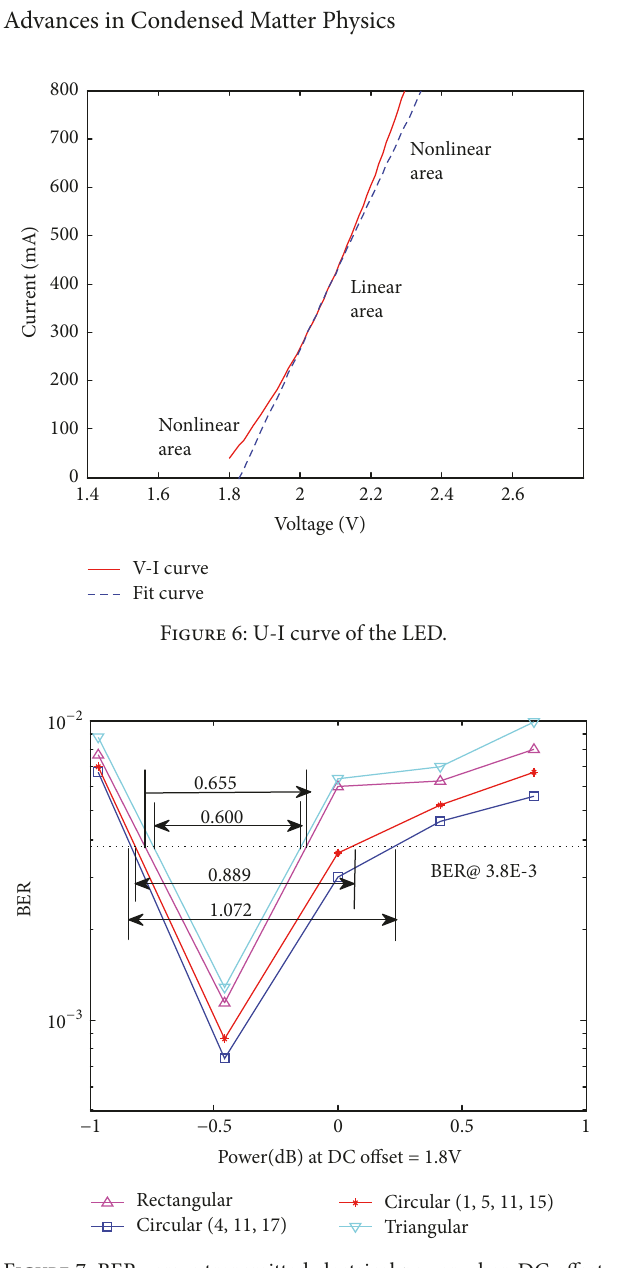
Figure 7: BER versus transmitted electrical power when DC offset is equal to 1.8V.